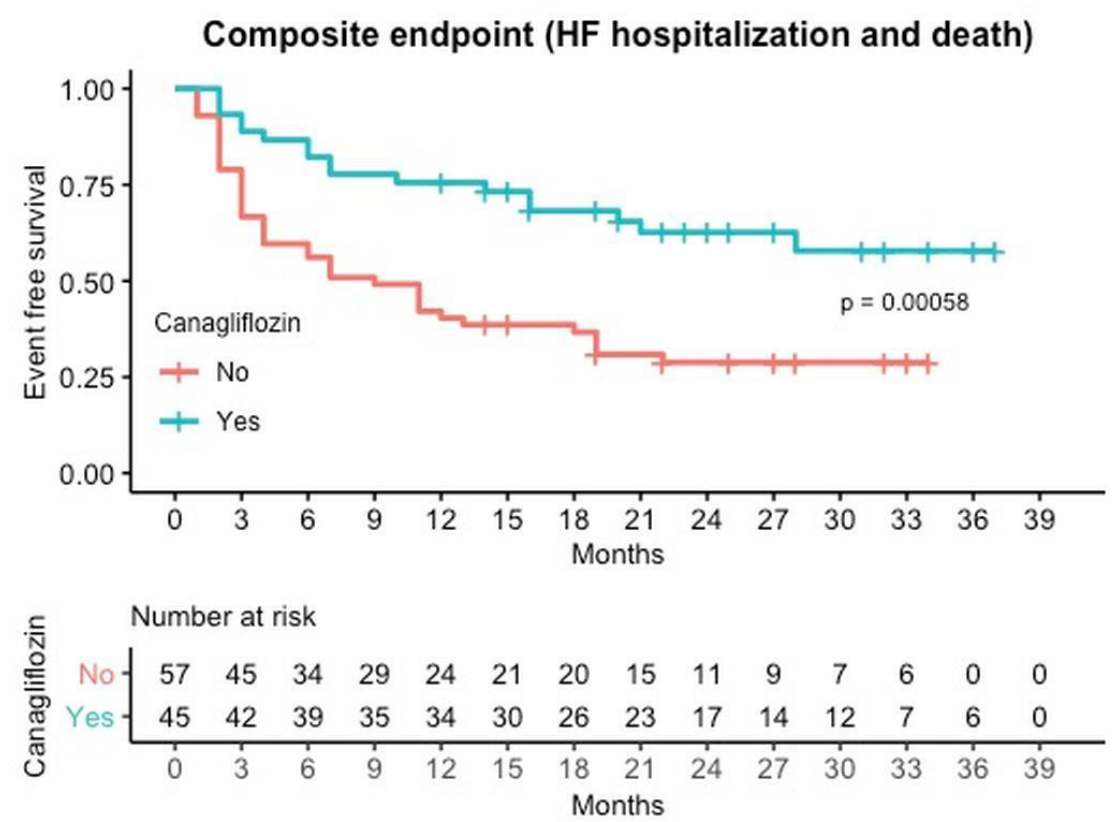
Figure 2. Event free survival curves for composite Mortality or Readmission by canagliflozin treatment.